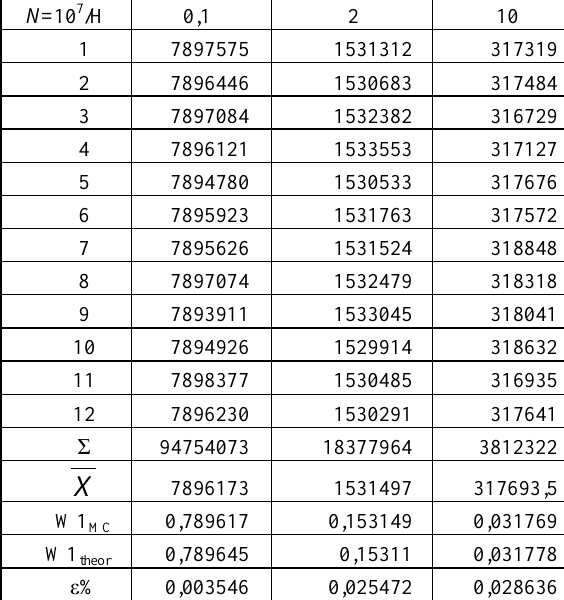
Table 2. The number of atoms ejected from the slit systems, depending on the relative height of the walls of the